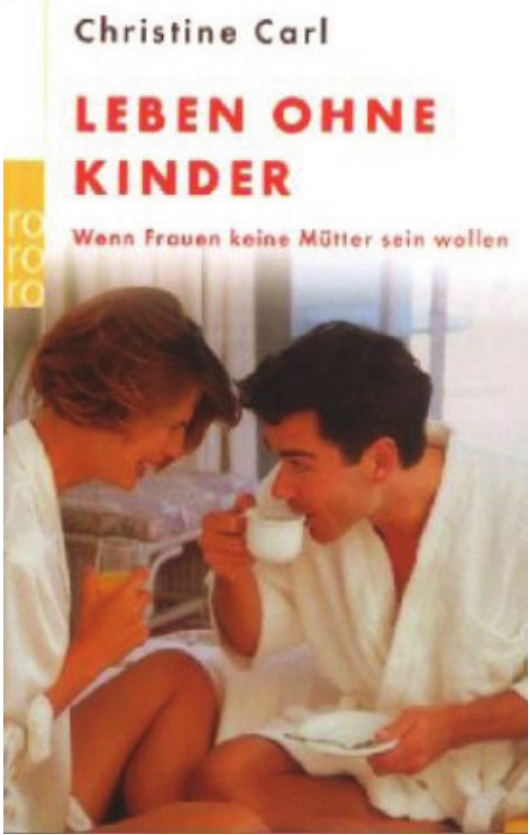
Figure 30. Book cover: Life Without Children. When Women Don’t Want To Be Mothers . Used by permission of Rowohlt